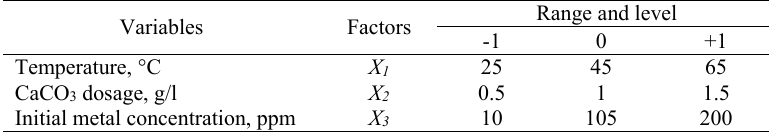
Fig. 1: Effect of pH on the adsorption of Pb 2+ and Fe 2+ Table 1: Experimental levels of independent parameters used in RSM design Fig. 1. Effect of pH on the adsorption of Pb 2+ and Fe 2+ ions. Table 1: Experimental levels of independent parameters used in RSM design